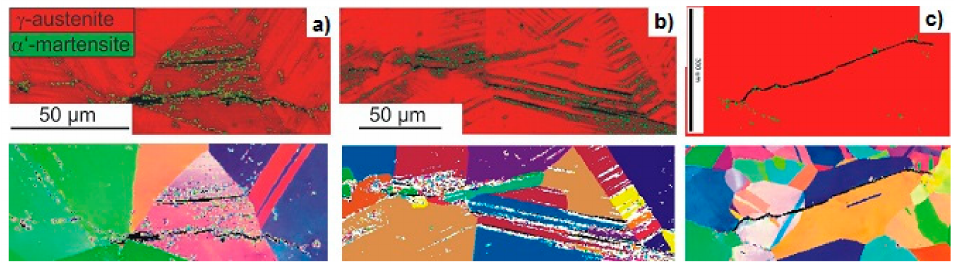
Figure 9. X2–12, EBSD images of the phase distribution and microstructure of ( a ) a crack in a precharged sample, ( b ) a crack in a reference (air) sample and ( c ) a crack in a pressurized hydrogen sample.